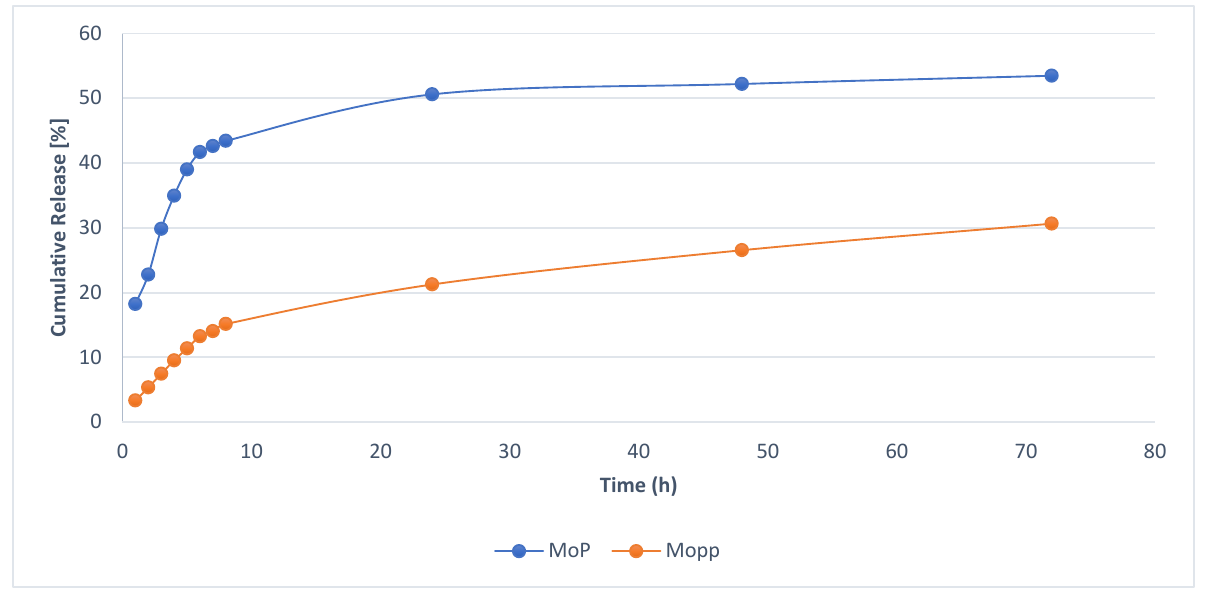
Table 4. Correlation coefficients for different kinetic models.